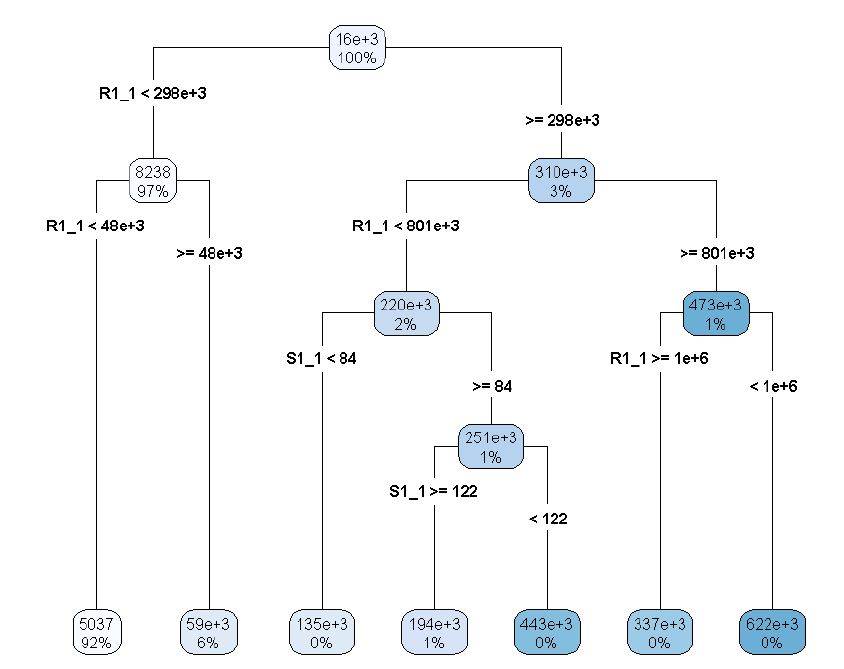
Figure 2. Severity model: pruned regression tree for claims in leaf 4 of the frequency tree.